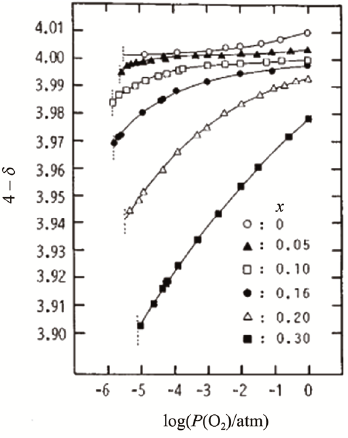
Fig. 5 Oxygen content in La (cid:2870)(cid:2879)(cid:3051) Sr (cid:3051) CuO (cid:2872)(cid:2879)(cid:3083) as a function of oxygen partial pressure at 900 ℃ . Oxygen deficiency is increasing with increasing Sr content. Reproduced with permission from Ref. [74], © Academic Press